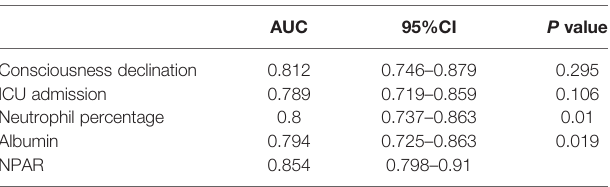
TABLE 4 | Comparison of AUC values between NPAR and other factors in predicting short-term